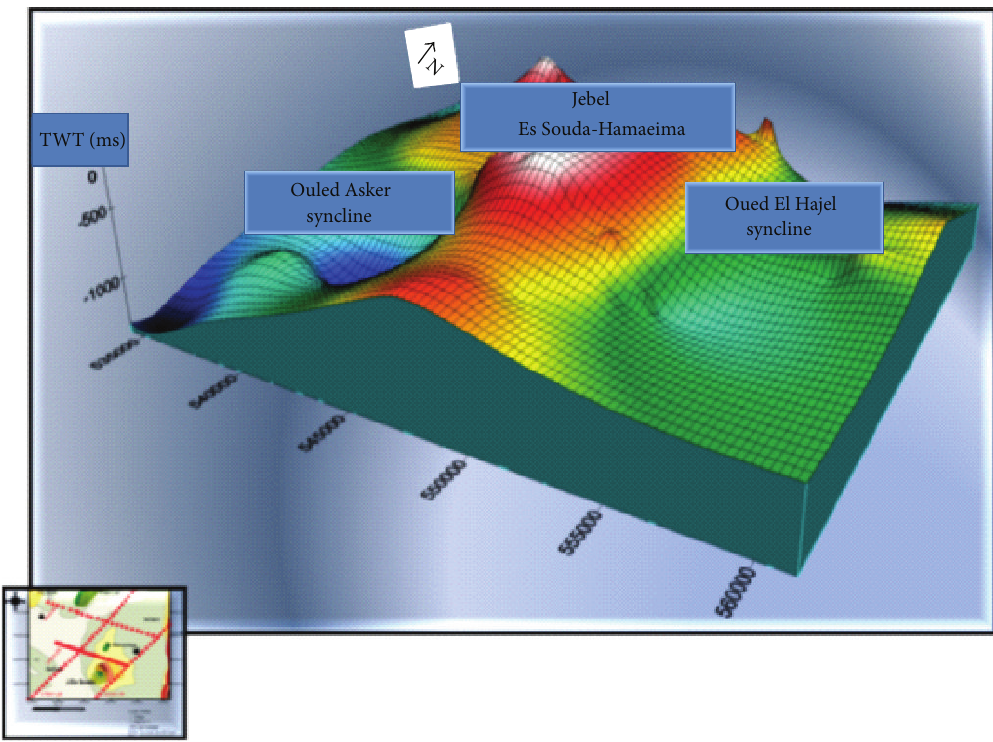
Figure 17: 3D visualization of the Upper Cretaceous